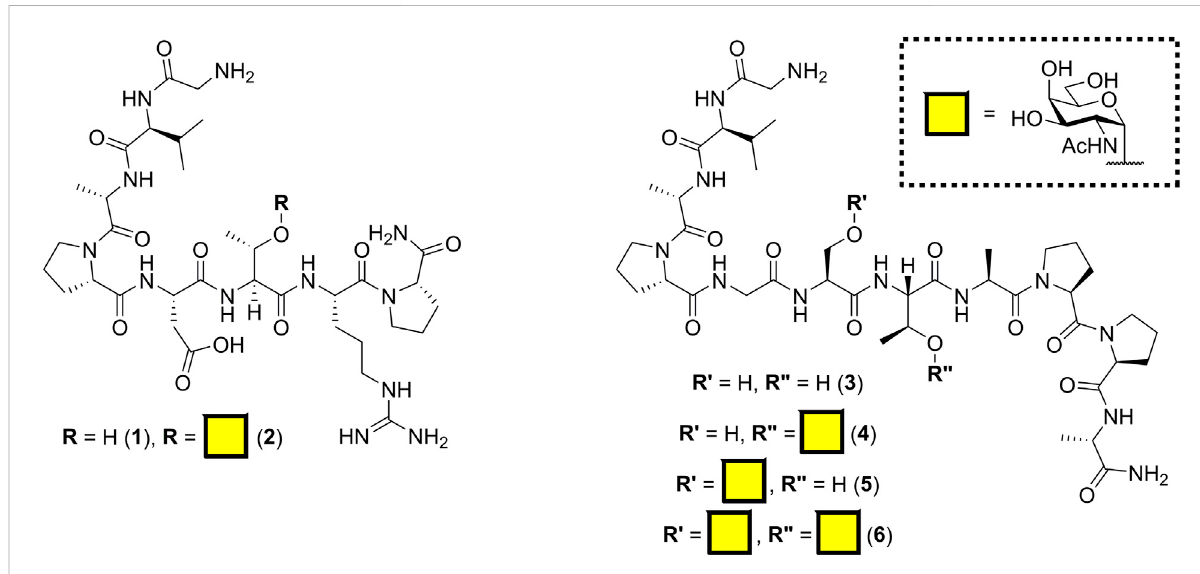
FIGURE 1 Structure of MUC1 (Tn) epitopes based on SM3 ( 1 – 2 ) and H-2D b ( 3 – 6 ) binding domains.